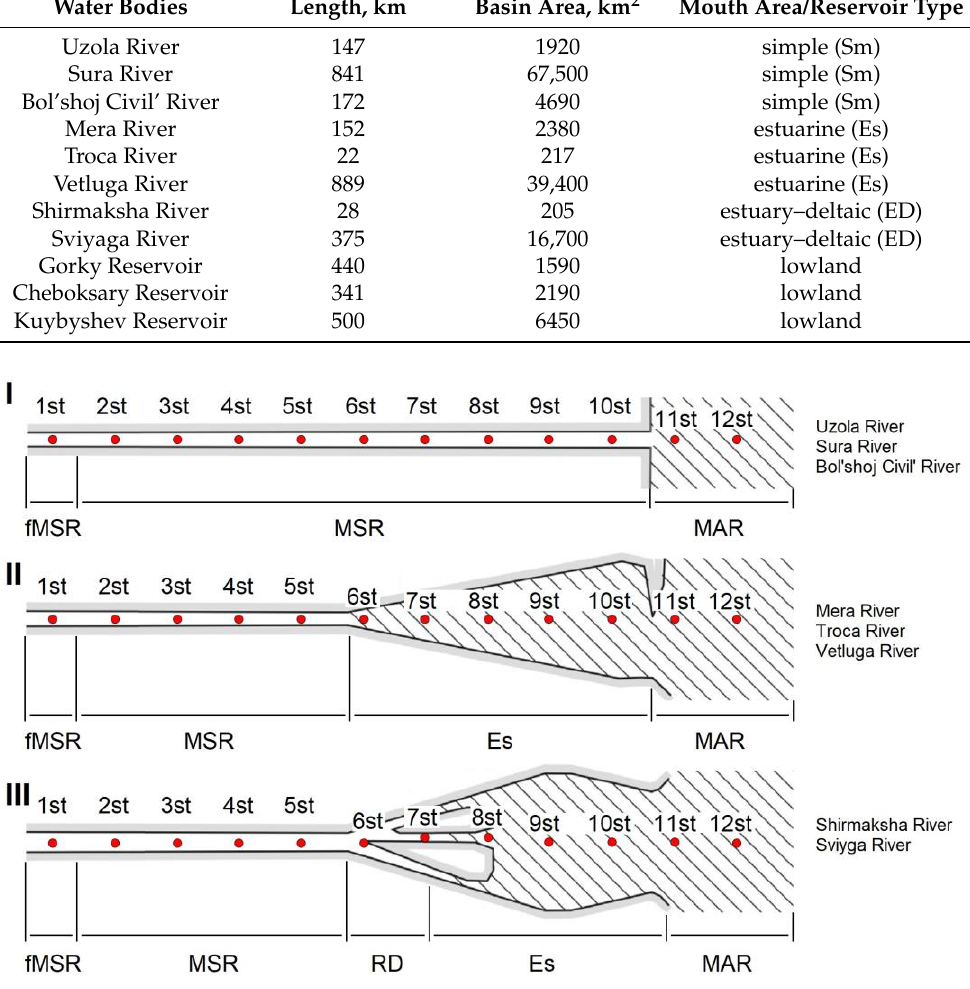
Figure 1. Scheme of mouth area types and zones. ( I ) — simple mouth area; ( II ) — estuarine mouth area; ( III ) — estuary – deltaic mouth areas. Mouth area zones: fMSR — front of mouth section river; MSR — mouth section river; RD — river delta; Es — estuary; MAR — mouth area of the reservoir. The mixing zone of river and reservoir water masses is highlighted with a shading line. The scheme is based on that of V. Mikhailov et al.